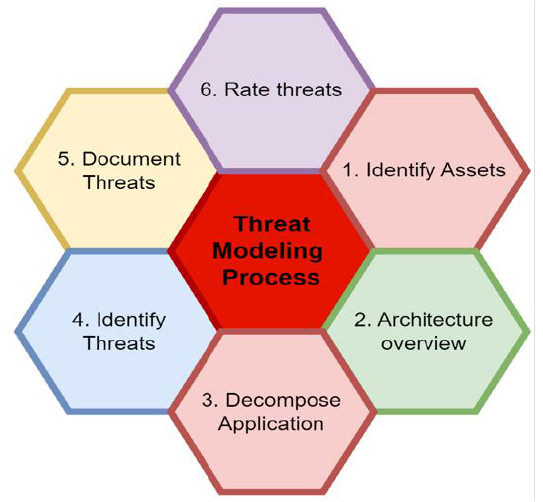
Figure 2. Threat-modeling process .